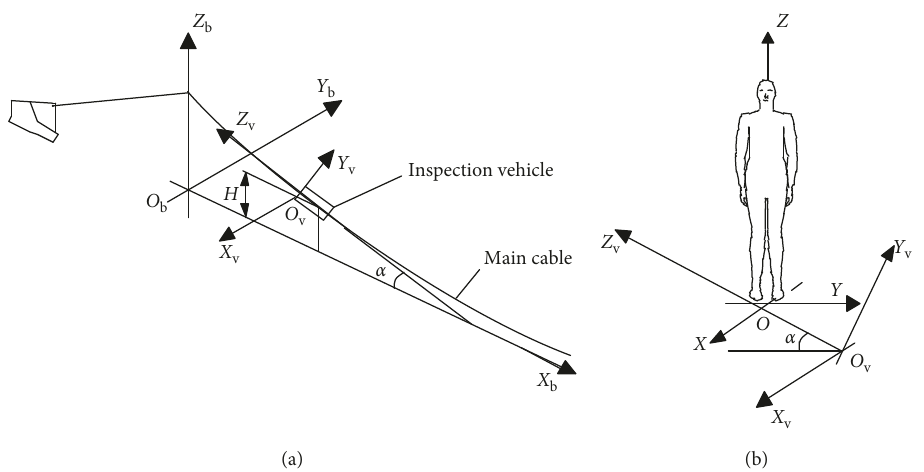
Figure 6: Coordinate relationship. (a) Bridge and vehicle. (b) Vehicle and worker.